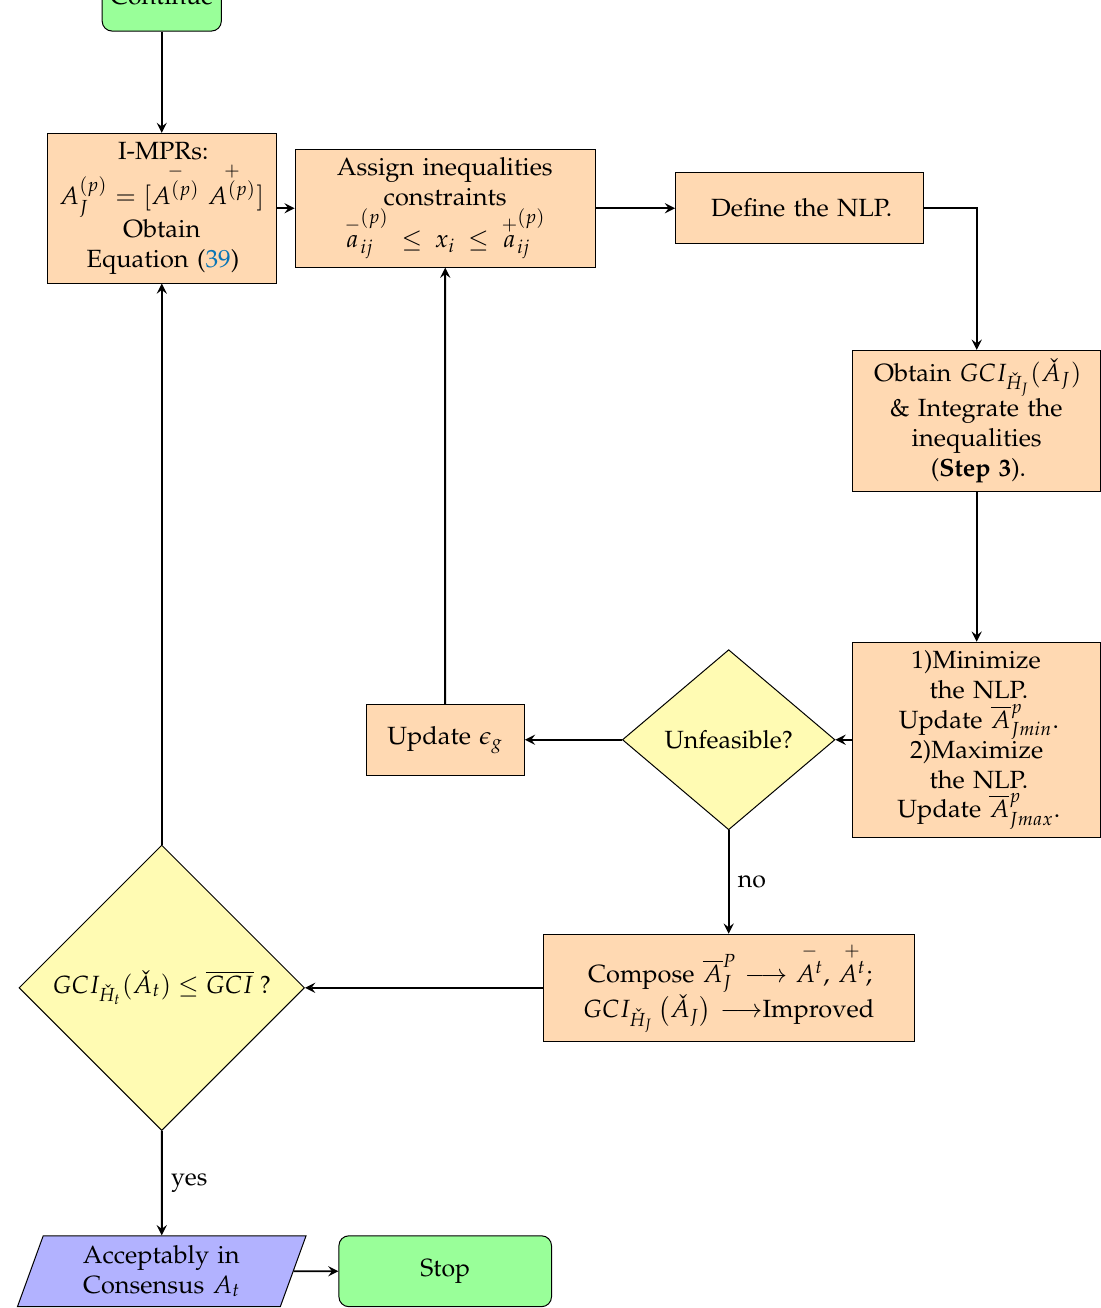
Figure 2. Process flowchart for improving consensus of